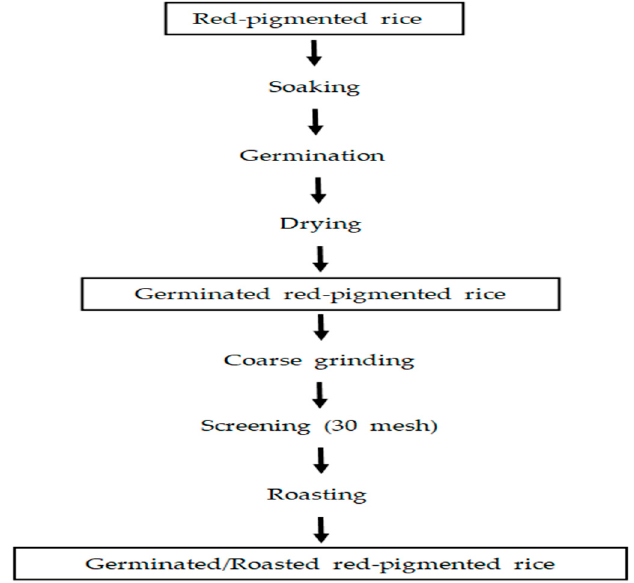
Figure 1. Procedure for producing germinated red-pigmented rice tea.